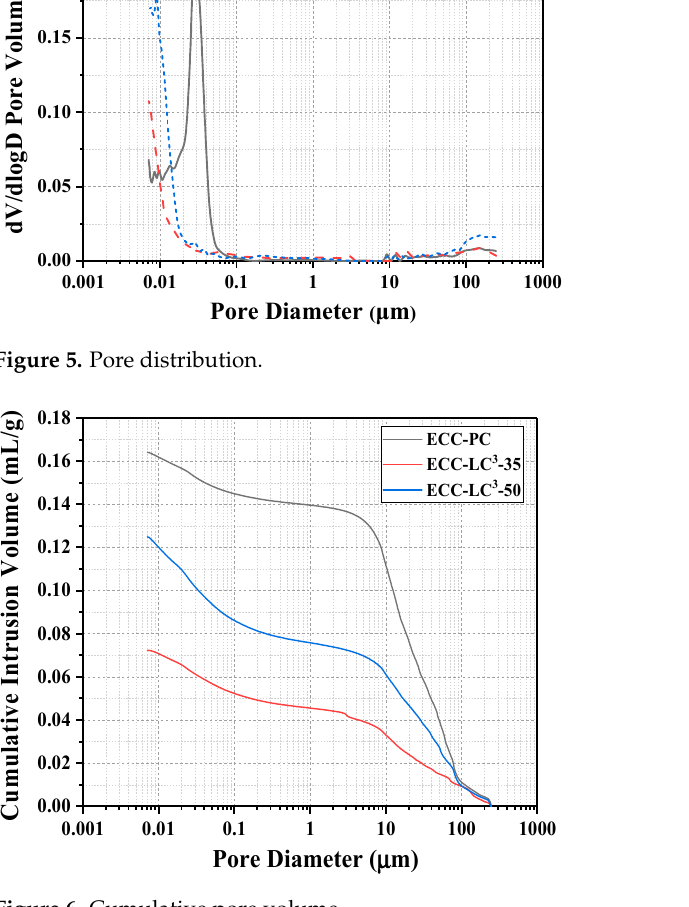
Figure 6. Cumulative pore volume. Table 4. Porosity of ECC matrix.